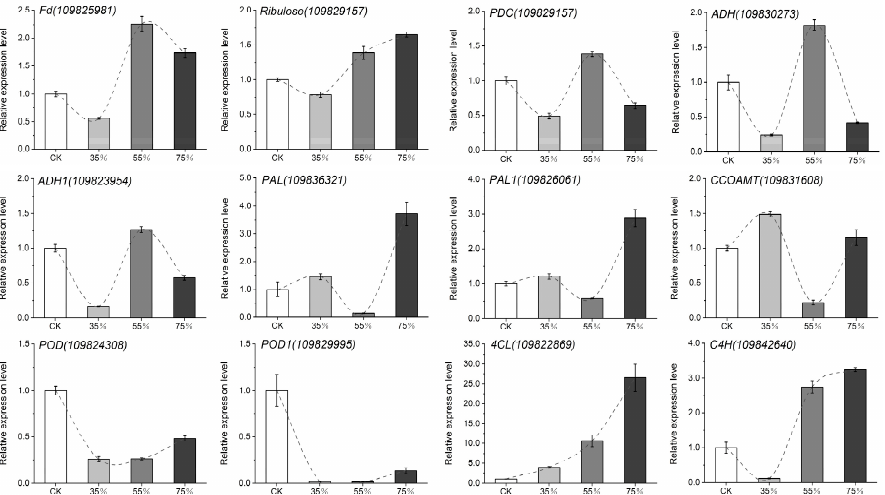
Figure 8. qRT-PCR analysis of asparagus under shading treatment. Relative expression levels of, Fd , Ribulose, PDC, ADH, ADH1, PAL , PAL1 , CCOAMT , POD , POD1 , 4CL and C4H . Each column represents the mean ± SD. T test at the significance level of 0.05 ( p < 0.05).